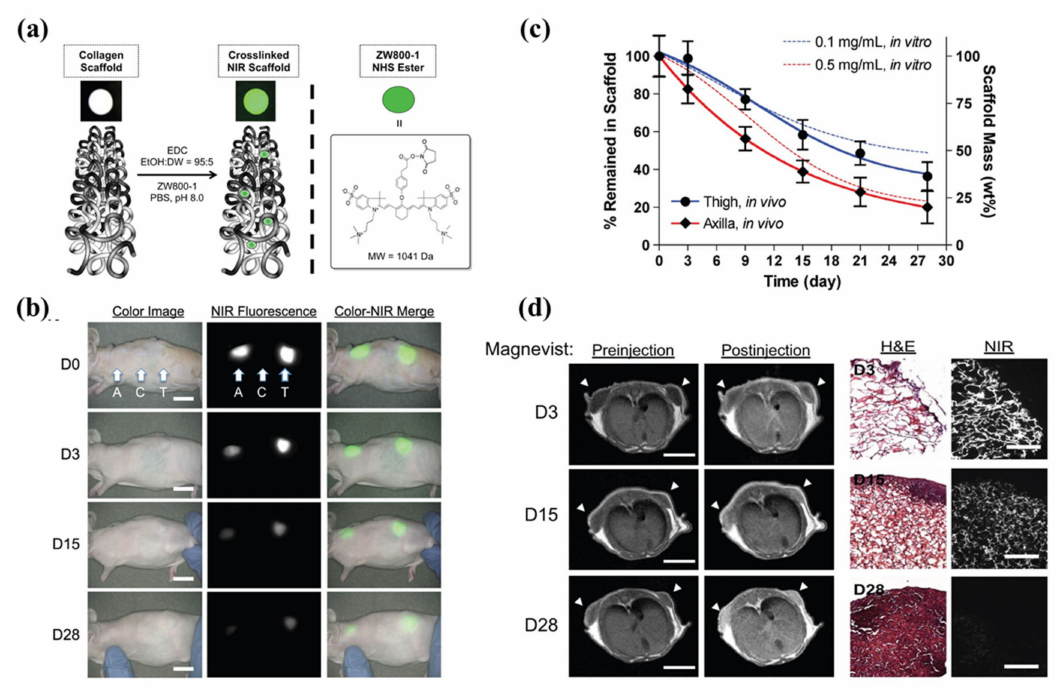
Figure6. Near-infrared(NIR)fluorophore(ZW800-1)-conjugatedcollagenscaffold. ( a )Schematicdrawing of NIR scaffold preparation and chemical structure of ZW800-1 NHS ester. ( b ) Optical